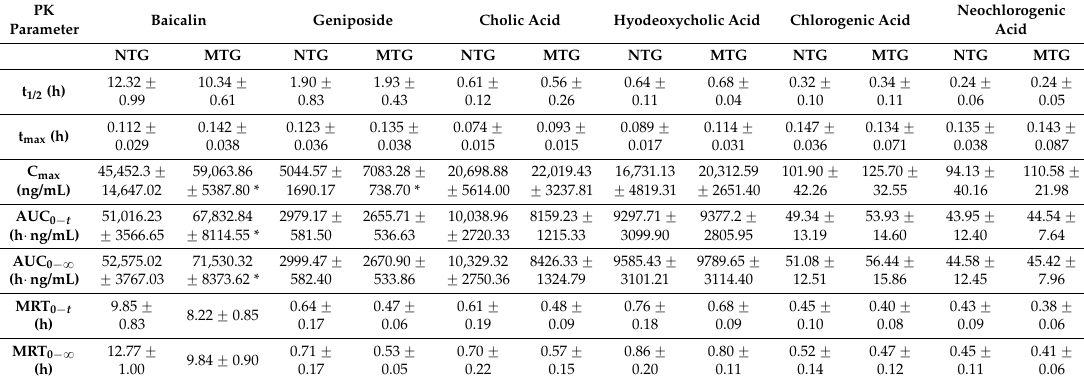
Figure 1. Plasma concentration-time profiles of six analytes in NTG and MTG rats after intraperitoneal administration of QKLI. Table 1. Pharmacokinetic parameters of six analytes in NTG and MTG rats after intraperitoneal administration of